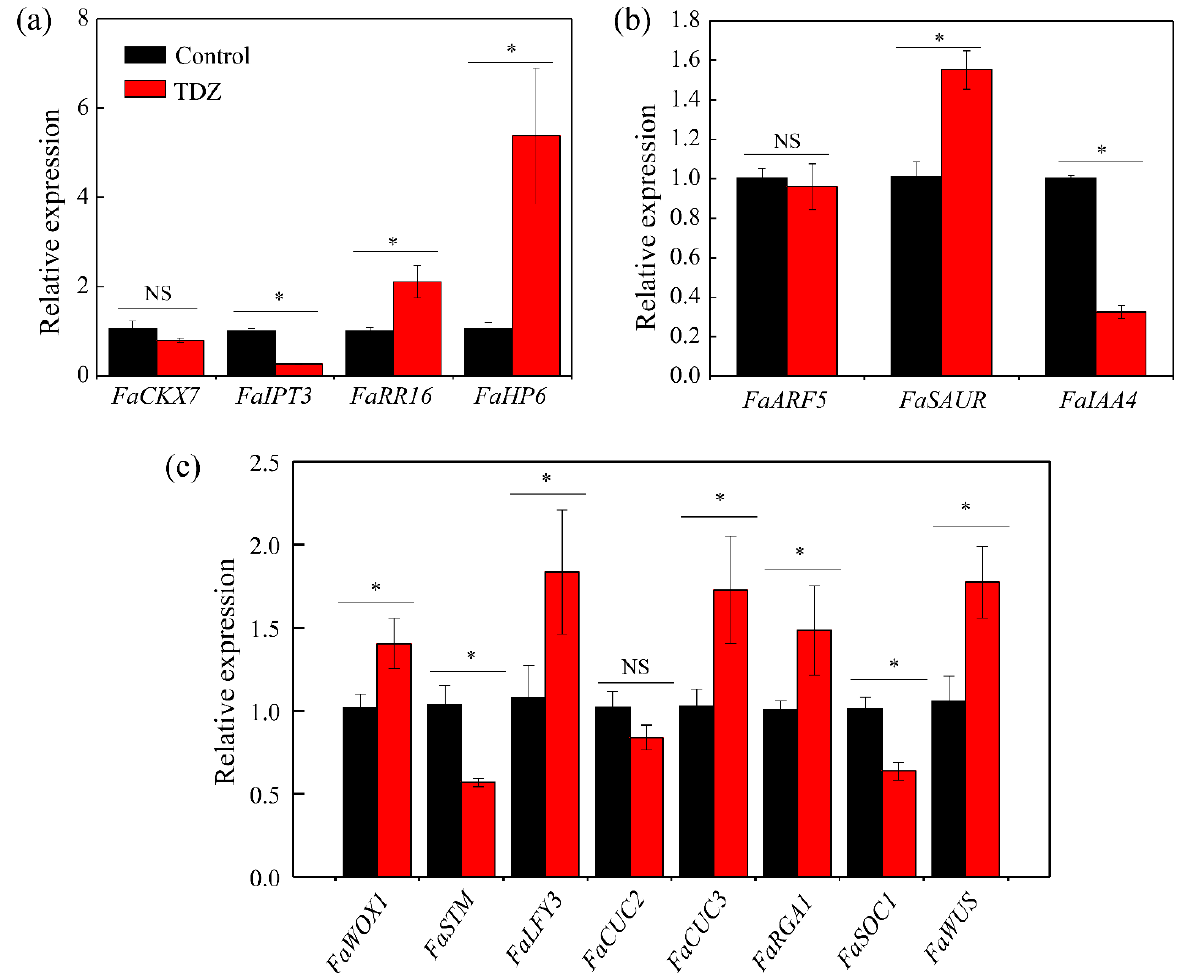
Figure 4. The effect of TDZ on the cytokinin ( a ) and auxin ( b ) metabolism-related genes and meristem-related transcriptional factors ( c ) in strawberry. The significant differences were calculated by Student’s t -test. NS, and * represent non-significant or significant at p ≤ 0.05, respectively.